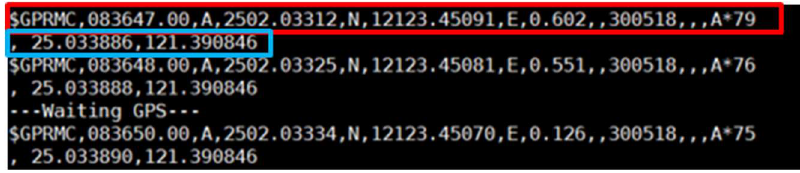
Figure 4. GPS output showing in NMEA format along with the converted coordinates.